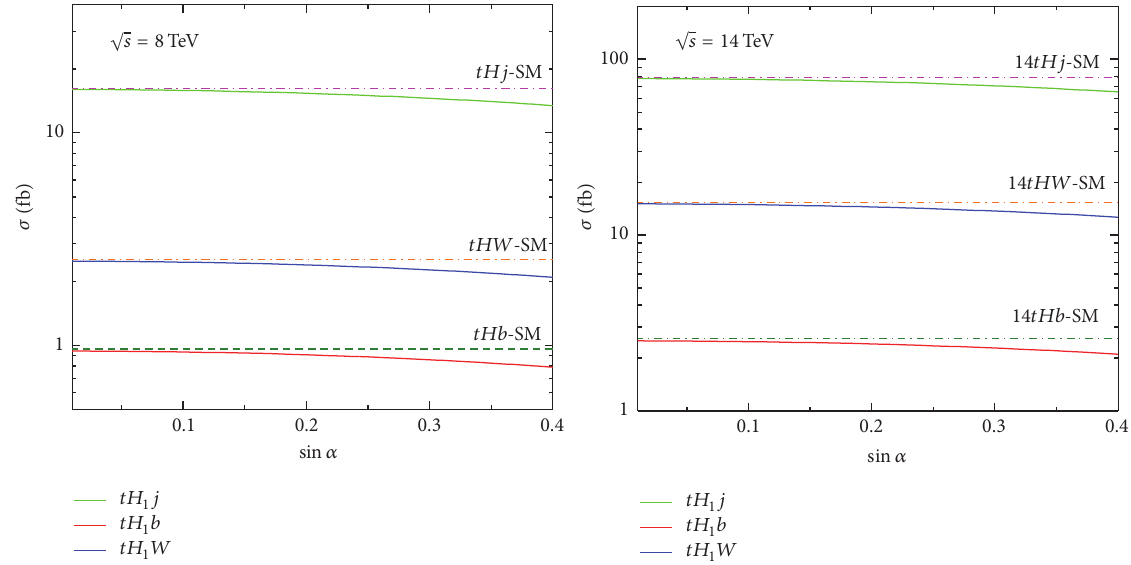
Figure 4: The production cross sections 𝜎 𝑡𝐻